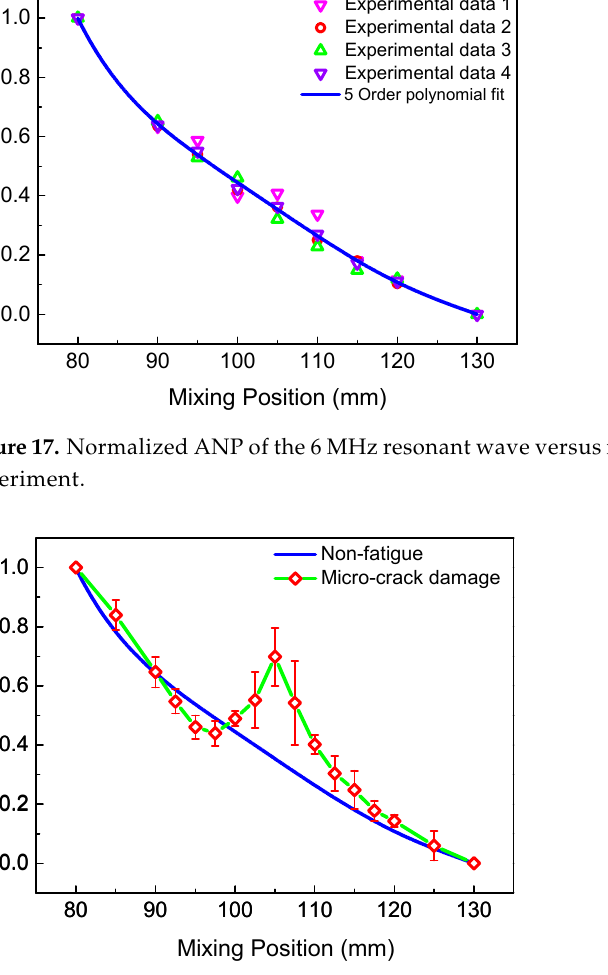
Figure 18. Normalized ANP of the 6 MHz resonant wave versus mixing position with non-fatigue and fatigue experiment.